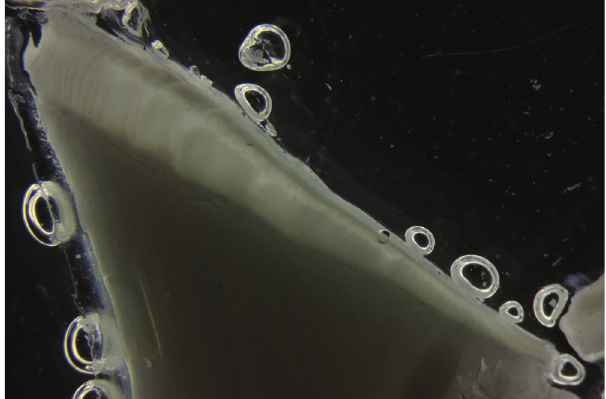
Figure 2. Sectioned vertebra from Blacknose Shark Carcharhinus acronotus L3384. Consensus band count was 22 band pairs (age = 20.5